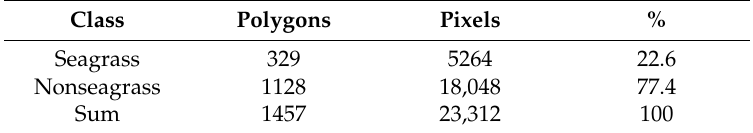
Figure 2. Scatter plots of the first four, sunglint-corrected Sentinel-2 bands depicting waveband reflectivity of the herein 1457 polygons for the whole extent of the study area. Seagrasses are in green circles and nonseagrasses are in light blue triangles. Table 1. Number of implemented polygons and pixels per class for our ~40,951 km² survey site.